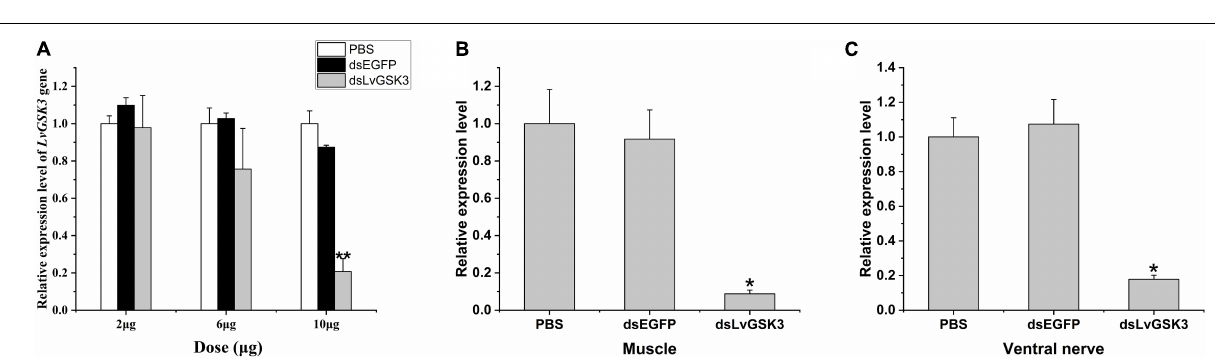
the activation segment of H. sapiens GSK3 β (Hughes et